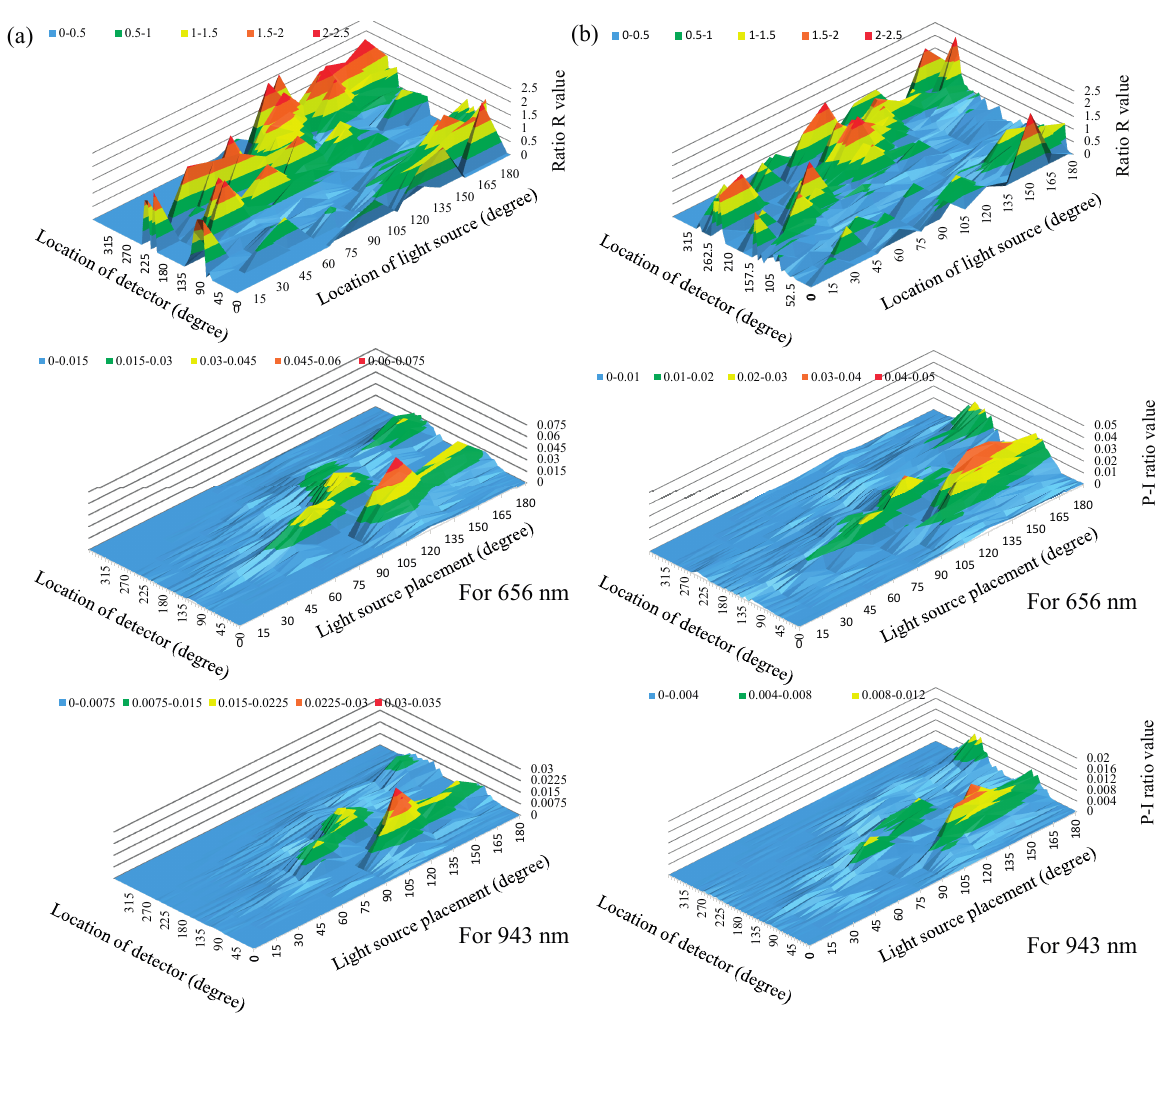
Figure 4. R ratio values and P-I (penetrated light to the incident light) ratio values of ( a ) Model 1 and ( b ) Model 2, corresponding to different locations of light sources and